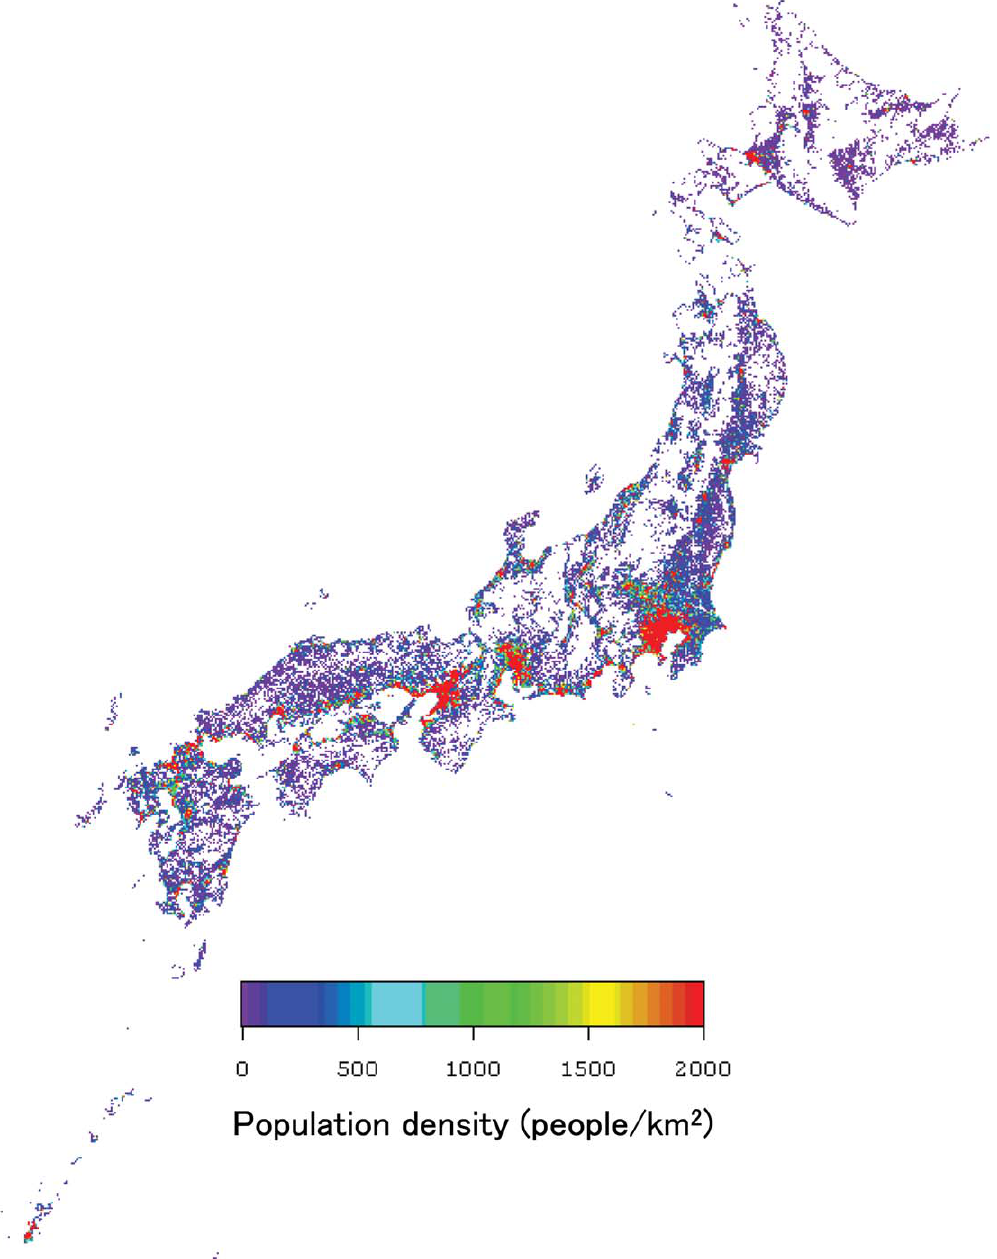
Figure 4. Distribution map of mesh population data in Japan. Mesh population data of 380,000 one-kilometer mesh areas has been shown. These data were derived from the results of the Population Census of 2005 and include population information by age and sex. The white areas indicate that there are no inhabitants.